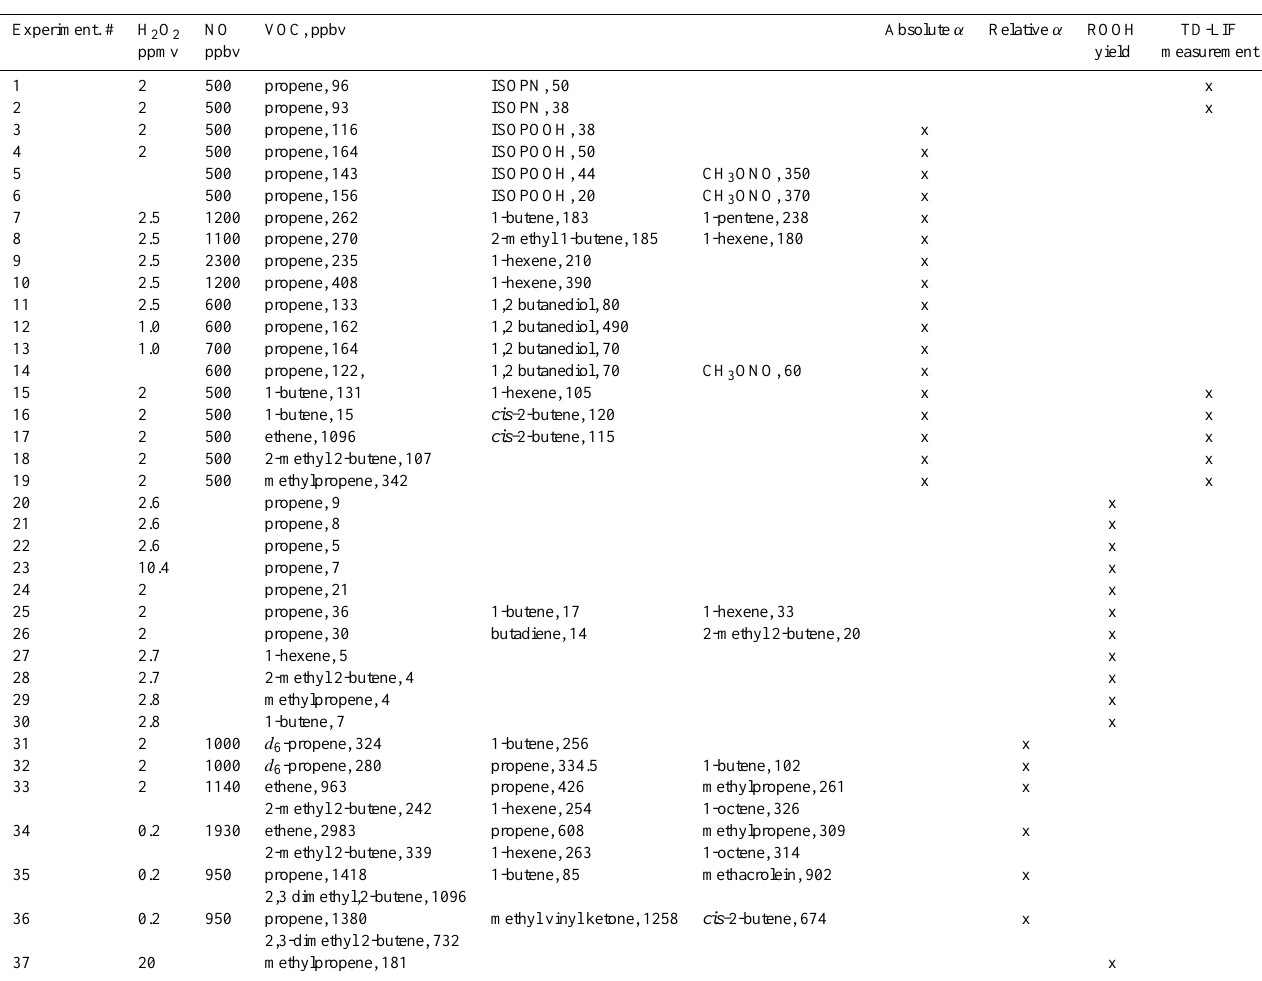
Table 1. Experiment